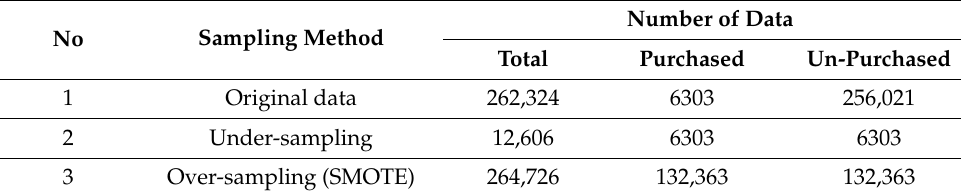
Table 6. Training data according to sampling